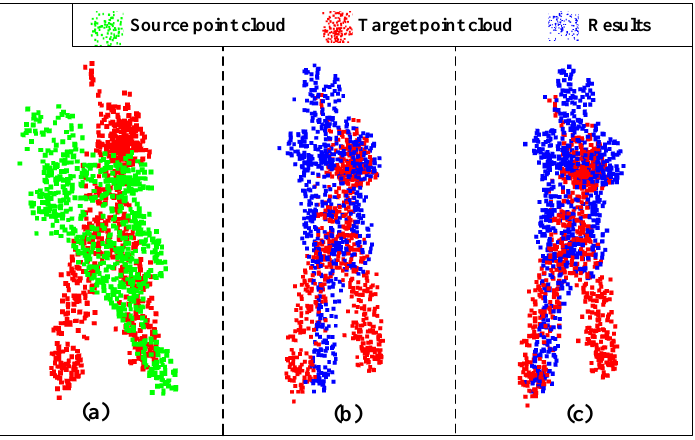
Figure 9. Registration visualization under 300 epochs with Gaussian noise: ( a ) input; ( b ) ROPNet; ( c )